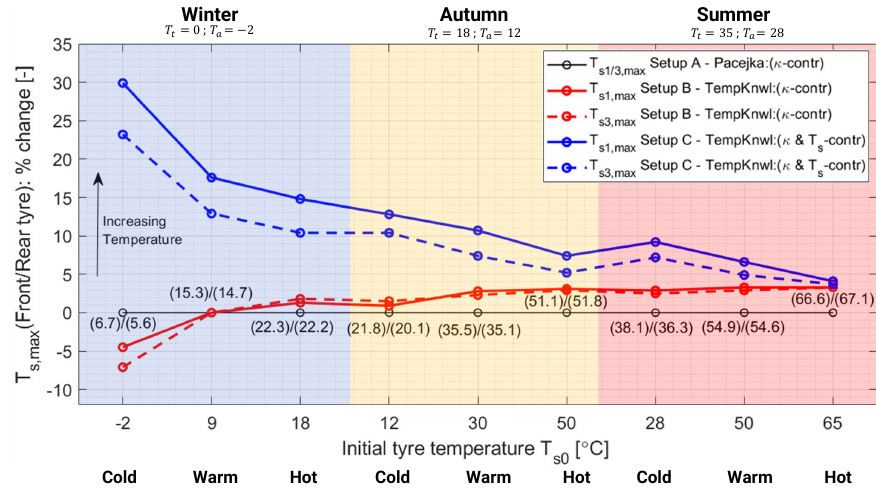
Figure 24. Percentage changes in maximum front and rear tyre tread temperature ( T s 1/3, max ) relative to Setup A starting at 40 m/s for tests 1–9, as shown in Figure 20. The absolute value of maximum temperature for Setup A is stated below each data point ( Front ) / ( Rear )